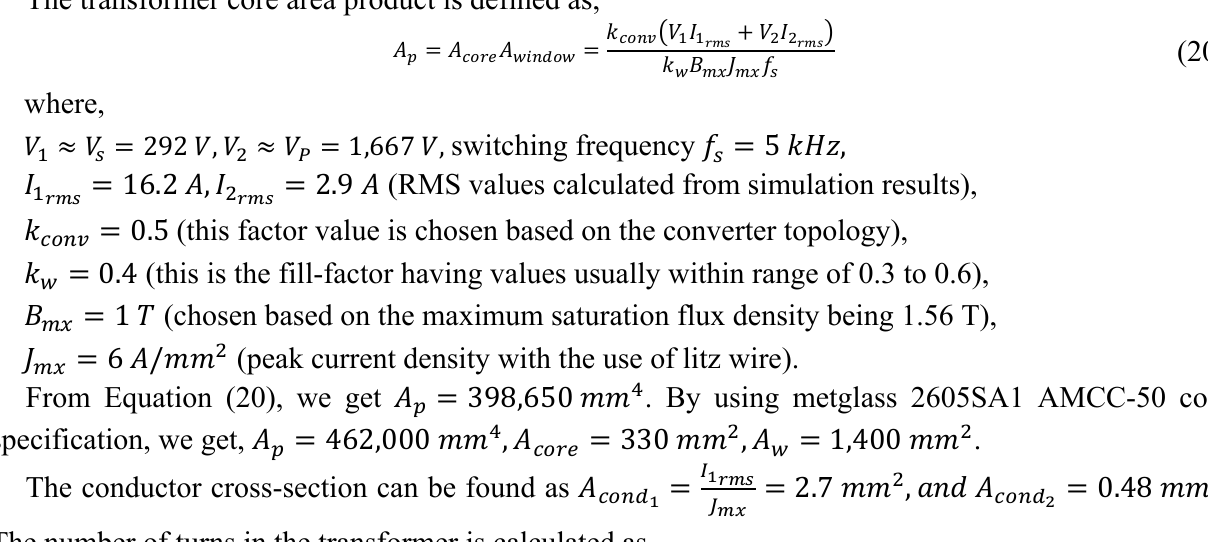
, inductor current (cid:1861) and (cid:1874) (cid:3002)(cid:3003) (cid:3028)(cid:3029)